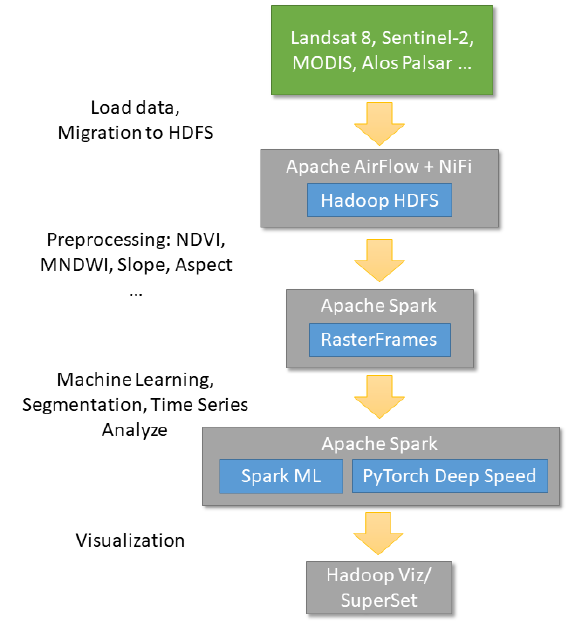
Figure 2 . Processing Pipeline.